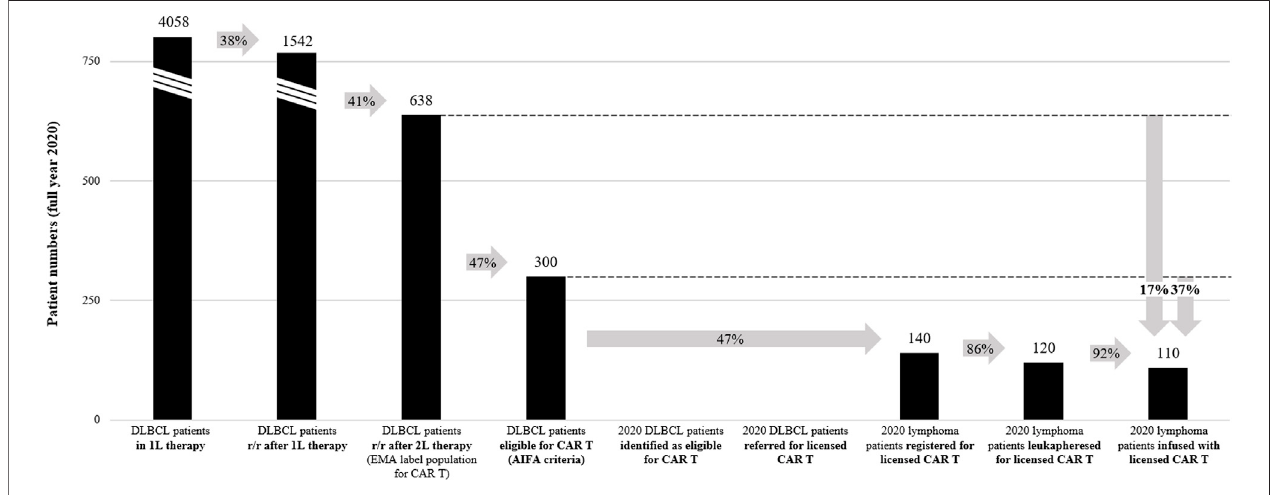
FIGURE 1 | 2020 DLBCL CAR T-cell therapy access analysis. Numbers in graph indicate the total patient numbers in Italy in 2020. Arrows indicate percentage of patients arriving at a speci fi c step of the patient journey relative to a previous step. See Supplementary Table S1 for calculations and references for the analysis. r/r, relapsed / refractory; 1L, fi rst-line; 2L, second-line.